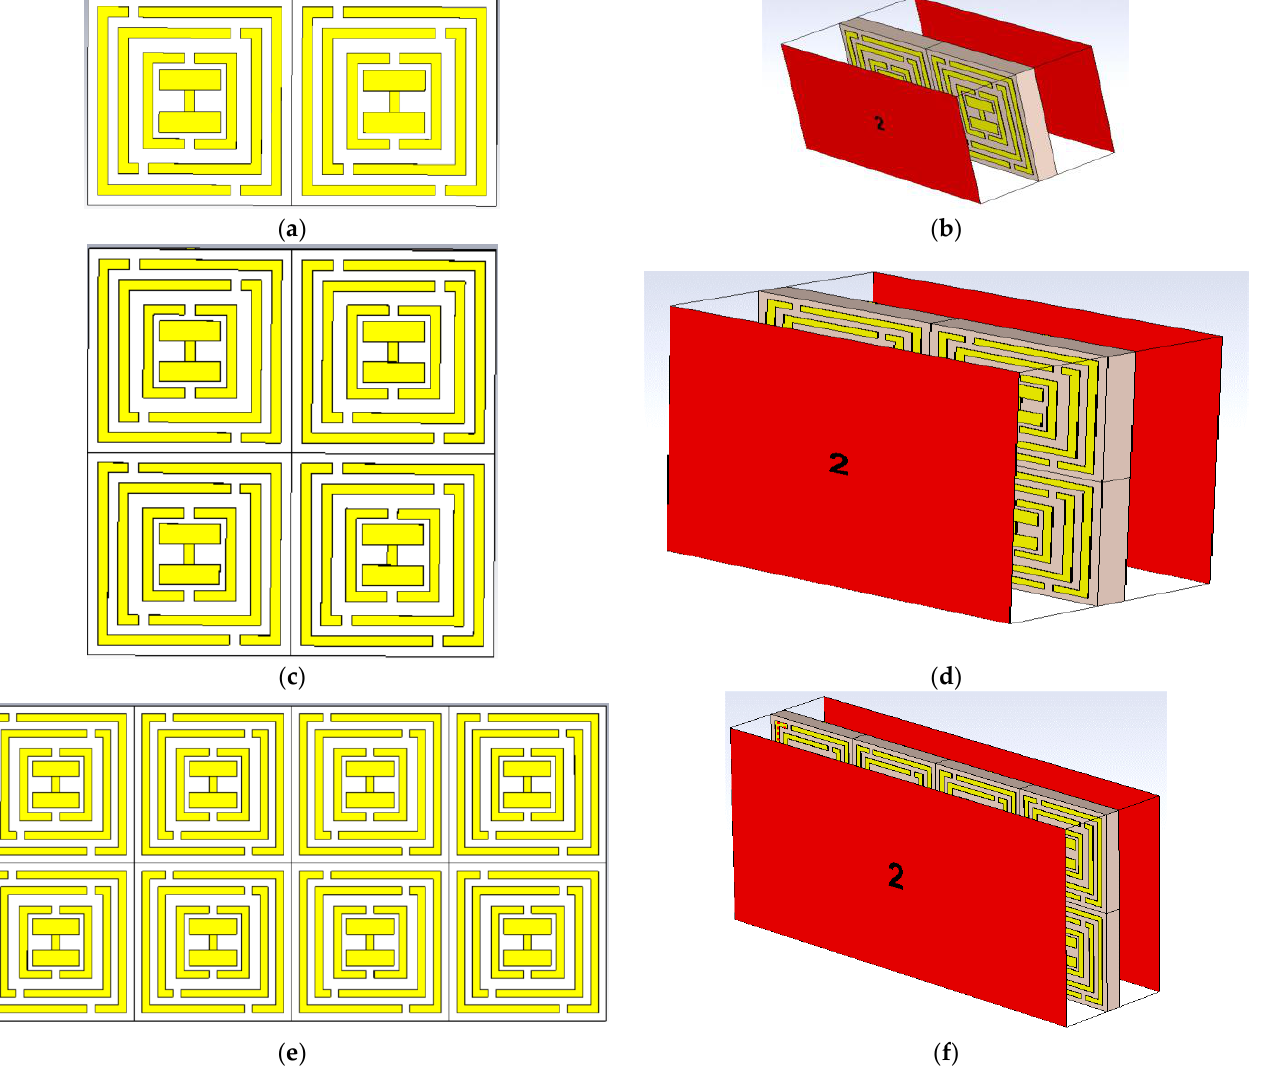
Figure 7. Schematic diagram of ISMeTM arrays: ( a ) geometry of 1 × 2 array; ( b ) simulated model of 1 × 2 array; ( c ) geometry of 2 × 2 array; ( d ) simulated model of 2 × 2 array; ( e ) geometry of 2 × 4 array; ( f ) simulated model of 2 × 4